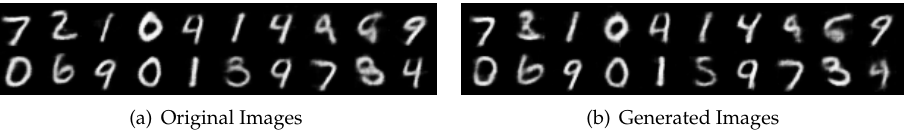
Figure 3. We provide random images generated from one of our VAEs trained on MNIST